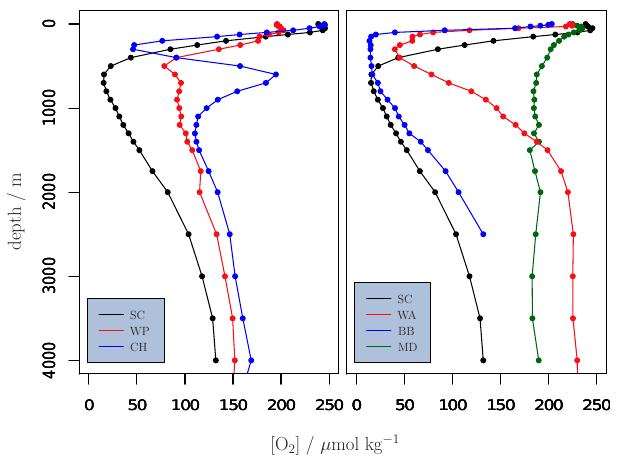
Fig. 1. [O 2 ] depth profiles of the water column at different hy- drographical stations around the world (SC: Southern California (120.5 ◦ W, 29.5 ◦ N); CH: Chile (75.5 ◦ W, 33.5 ◦ S); WP: West- ern Pacific (126.5 ◦ E, 11.5 ◦ N), WA: Western Africa (6.5 ◦ E, 15.5 ◦ S), MD: Mediterranean (18.5 ◦ E, 35.5 ◦ N); BB: Bay of Ben- gal (87.5 ◦ E, 18.5 ◦